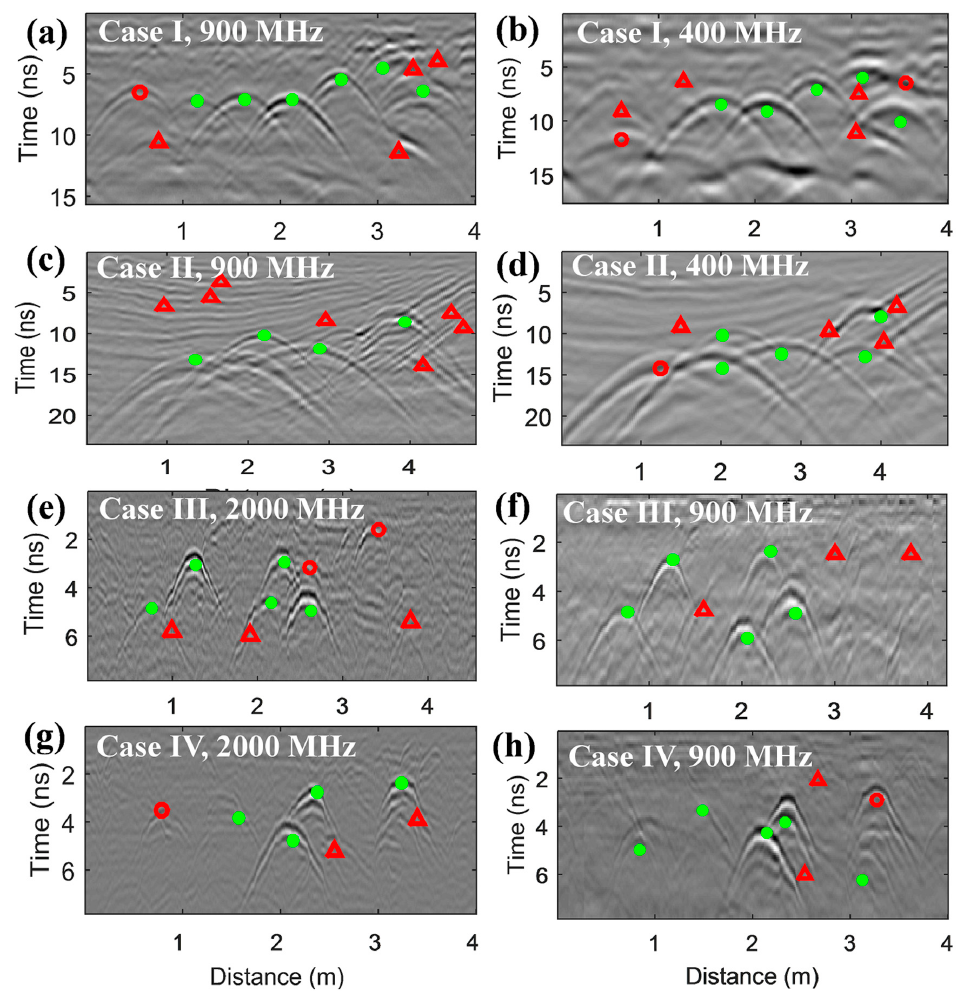
Figure 6. Results of recognition by RHT for the four in situ cases with different center frequencies. Case I in Xilingol League with ( a ) 900 MHz and ( b ) 400 MHz; Case II in Jingbian with ( c ) 900 MHz and ( d ) 400 MHz; Case III in Wushen Banner with ( e ) 2 GHz and ( f ) 900 MHz; Case IV in Otog Front Banner with ( g ) 2 GHz and ( h ) 900 MHz. The roots correctly recognized by RHT are marked with green points. The missed roots are marked with red circles and the false alarms are marked with red